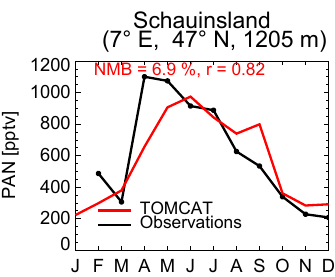
Figure 15. Monthly mean 2008 observed and simulated PAN (pptv) at the Schauinsland mountain observatory in